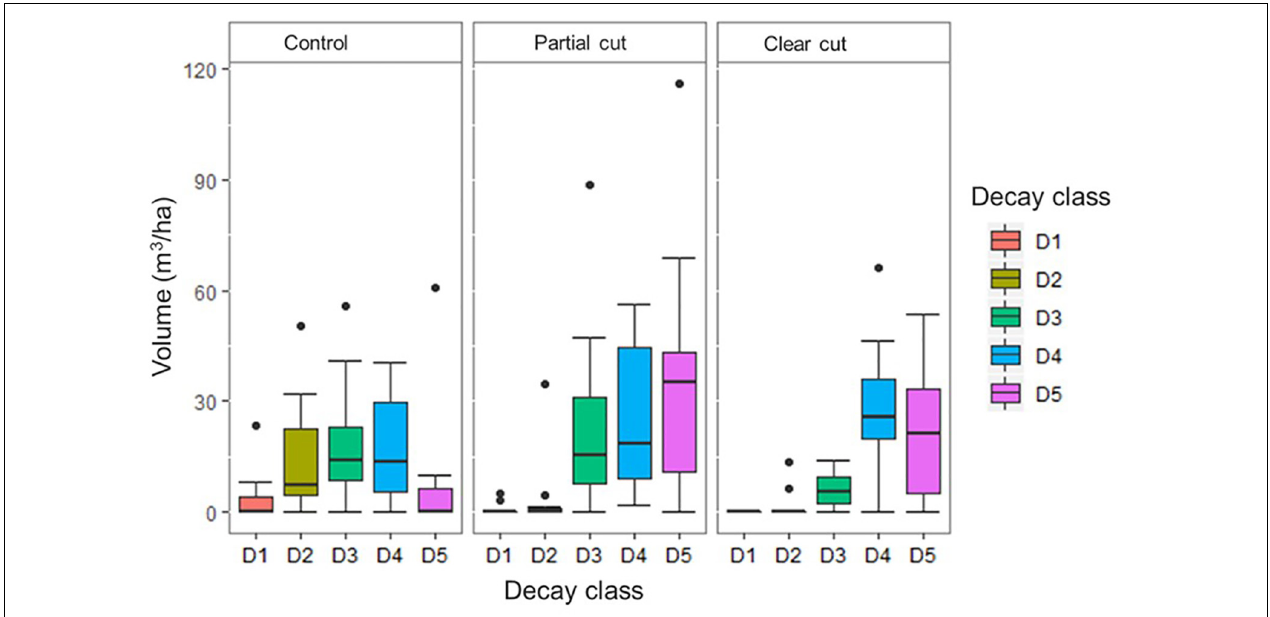
FIGURE 1 | Coarse woody debris volume by decay class per harvest treatment at the plot level ( n = 30). Control (CT), Partial cut (PC), Clear cut (CC) and Decay class 1 to 5 (D1, D2, D3, D4, and D5). The dark horizontal lines in the box and whisker plots represent the median, with the box representing the 25 and 75th percentile and the whiskers the 5 and 95th percentiles and the dots represents outliers.